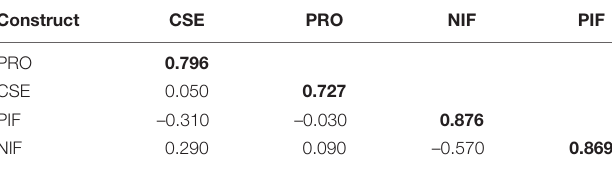
TABLE 4 | Discriminant validity and correlations.